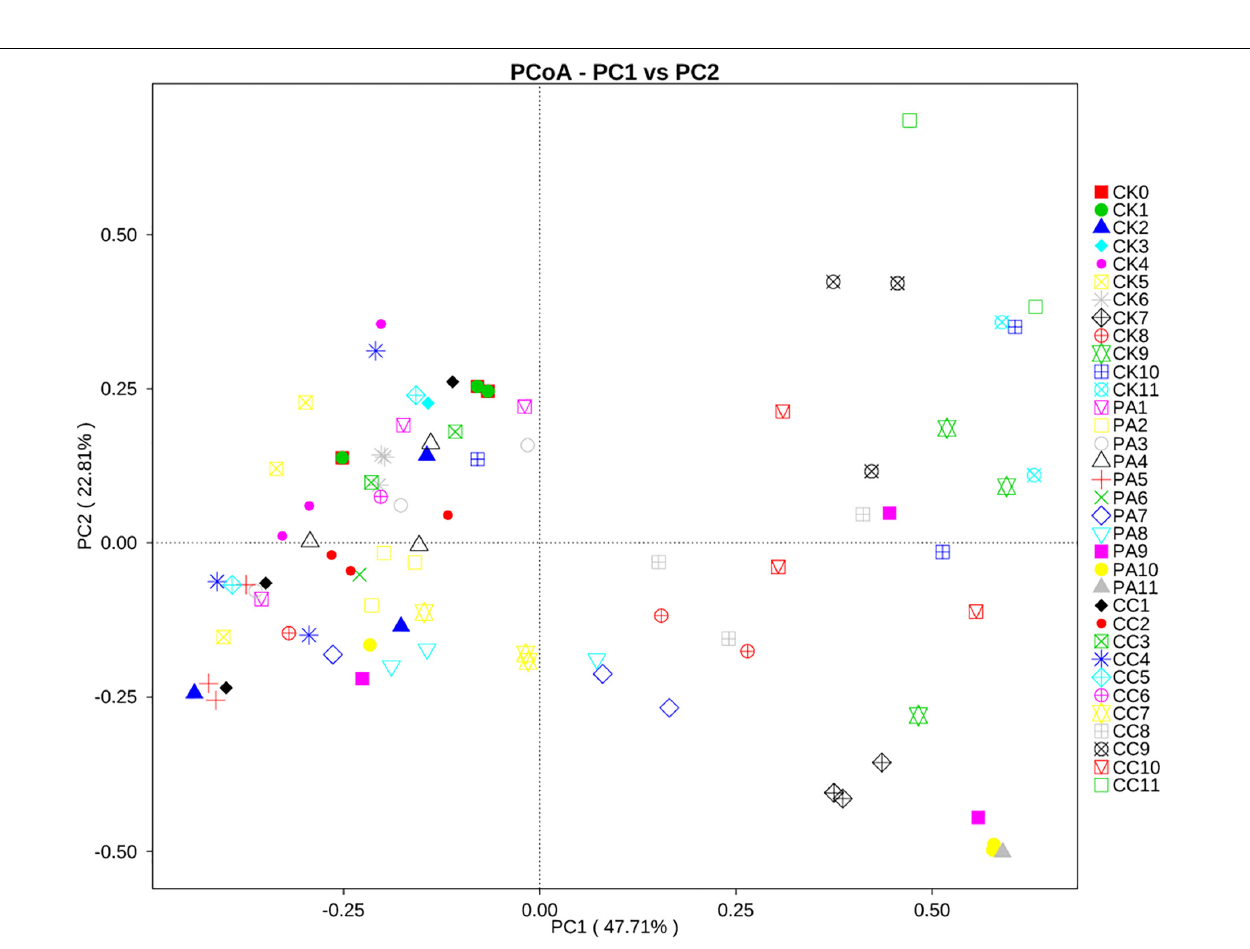
Frontiers in Microbiology |